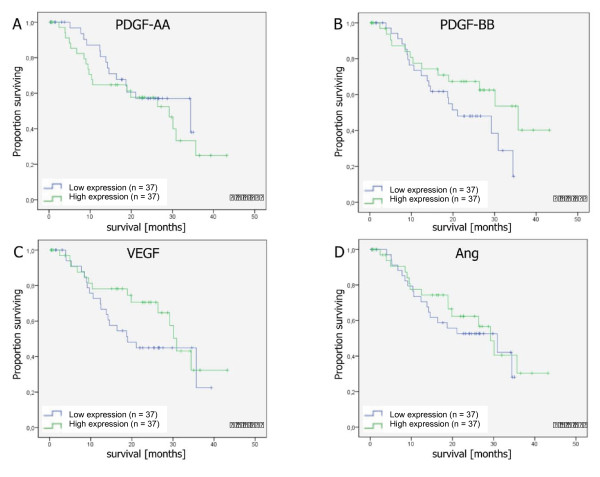
Kaplan-Meier plots of circulating angiogenic cytokines that had significant associations with cancer-specific survival on multivariate analyses. P-values refer to the results of univariate analyses (log-rank test).